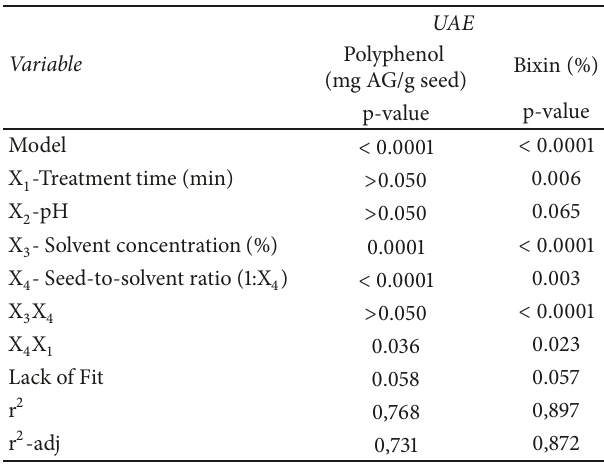
Table 2: ANOVA table for the response variables for the UAE of bioactive compounds from annatto